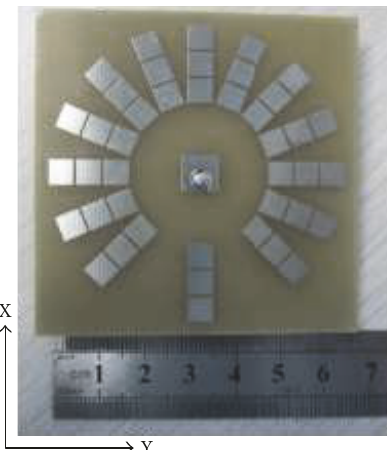
Figure 10: The con fi guration and photograph of antenna with fi nal GCRA-AMC.